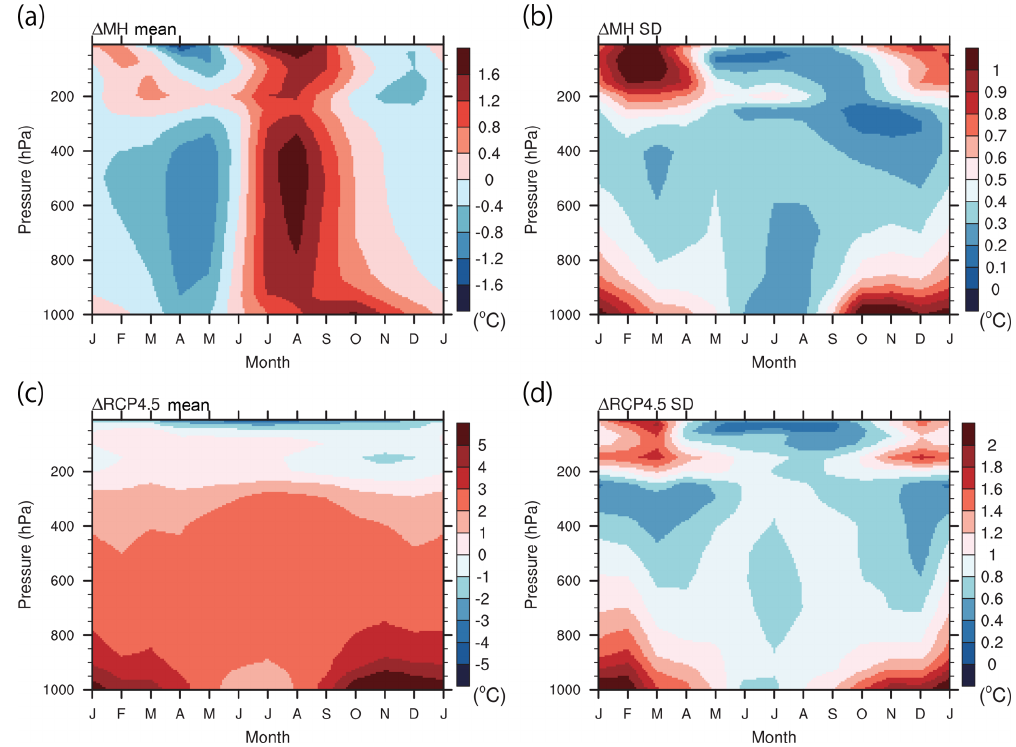
Figure 7. Same as in Fig. 6 but for the air temperature change ( ◦ C) (north of 60 ◦ N). All 10 models listed in Table 2 are used. (Note that the figure appears blocky compared to Fig. 6 due to the use of a different interpolation scheme in the plotting software which was chosen to avoid a technical issue for pressure coordinate, but it is irrelevant to the